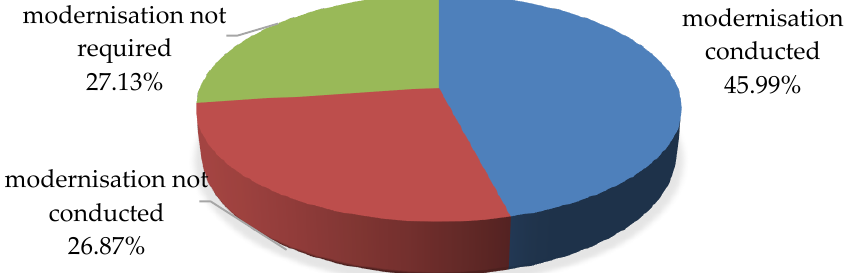
Figure 9. State of residential buildings of the studied households. N = 387.